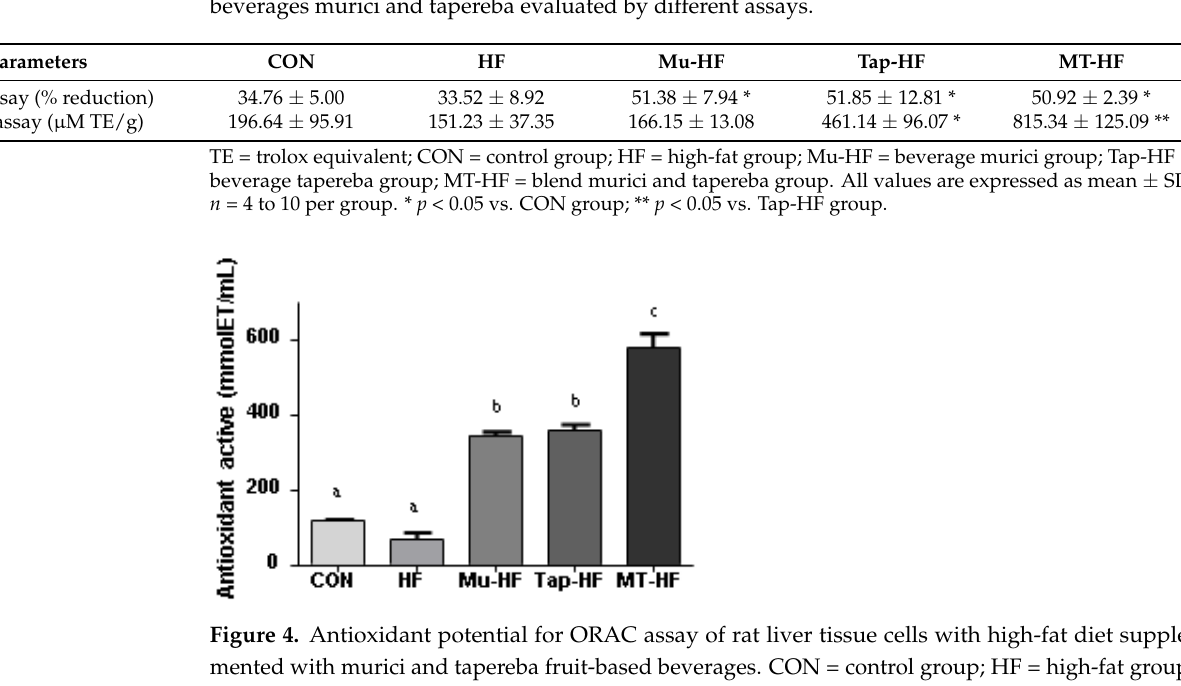
mean ± SD. n = 4 to 10 per group. Means with different letters are significantly different ( p < 0.05, Tukey’s test).